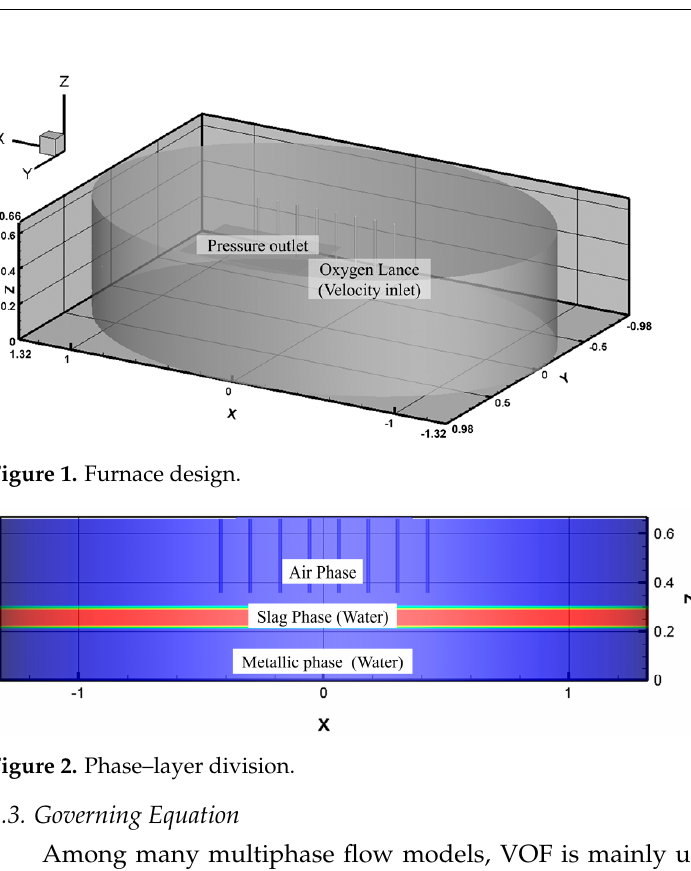
Figure 2. Phase–layer division.